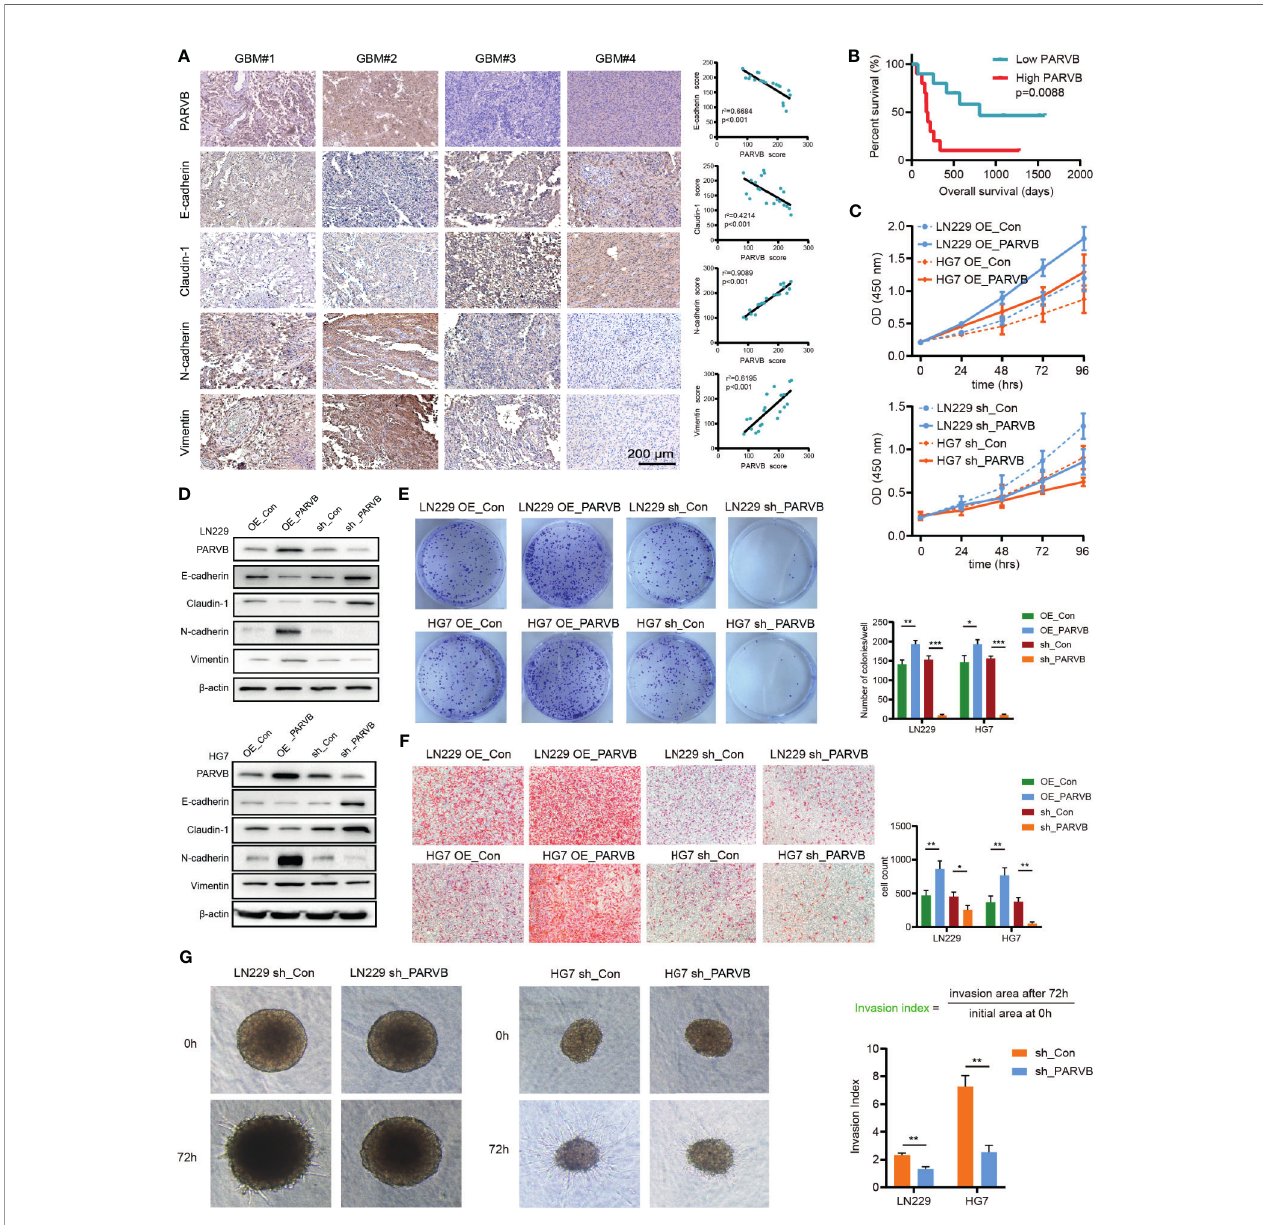
FIGURE 8 | PARVB regulates proliferation, migration, invasion, and EMT in vitro of GBM cells. (A) Immunohistochemistry (IHC) analysis was performed on twenty GBMs, representative images of 4 GBMs (GBM#1 and GBM#2 high PARVB expression, GBM#3 and GBM#4 low PARVB expression) are shown. IHC of epithelial markers (E-cadherin and Claudin-1), mesenchymal markers (N-cadherin and Vimentin), and PARVB in tumor sections from GBM samples. Scale bar = 200 m m. PARVB score was positively correlated with the mesenchymal markers (N-cadherin and Vimentin) score and negatively correlated with the epithelial markers (E-cadherin and Claudin-1) score. (B) Kaplan-Meier analysis in low expression and high expression PARVB groups in 20 GBM patients: the green dots represent low expression PARVB patients and red dots represent high expression PARVB patients. (C) CCK-8 analysis show that overexpression of PARVB accelerates the proliferation and PARVB knockdown reduces the proliferation in LN229 and HG7 cells at the indicated times. (D) Western blot analysis of the indicated proteins in LN229 and HG7 GBM cells after PARVB overexpression or knockdown. Result shows that PARVB expression was positively correlated with mesenchymal marker (N-cadherin and Vimentin), and negatively correlated with epithelial marker (E-cadherin and Claudin-1) in LN229 and HG7 cells. (E) Colony formation assay shows that PARVB overexpression promotes the proliferation and PARVB knockdown reduces the growth of LN229 and HG7 GBM cells in a 6-well dish (800 cells per well) for 8 days (n = 3). Representative images of colonies are shown. The assays were determined from three independent experiments, quanti fi cation data are expressed as average ± SD. (F, G) Transwell migration analysis and 3D spheroid cell invasion assay showing the effect of PARVB overexpression and knockdown on the LN229 and HG7 GBM cells. Representative images and statistical analysis of three independent assays are shown, quanti fi cation data are expressed as average ± SD. Signi fi cant results are indicated as *p < 0.05, **p < 0.01, and ***p <